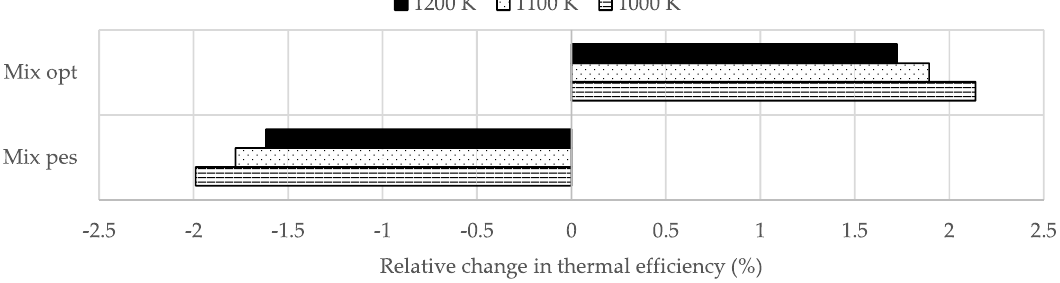
Figure 9. Relative changes of thermal efficiency for Mix models at different temperature constraints for the simple